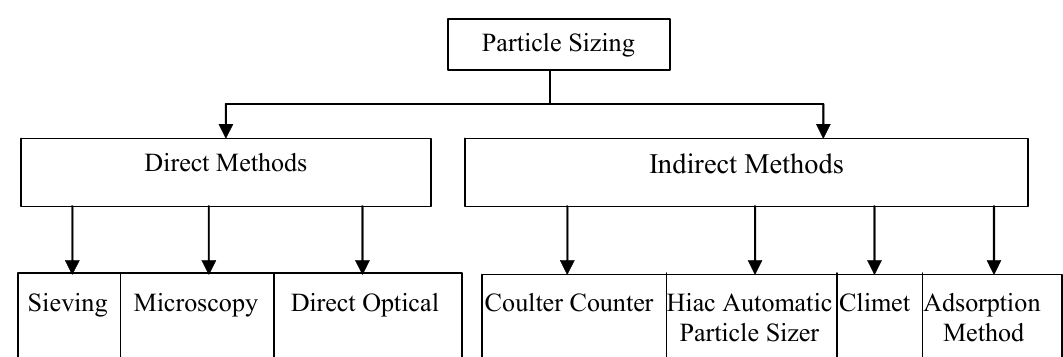
Figure 1. A block diagram of particle sizing